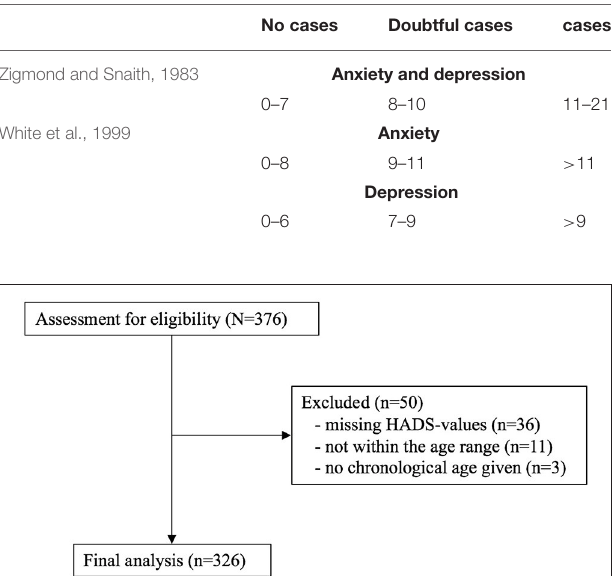
TABLE 1 | Anxiety and depression cut-offs for the adult and adolescent population.